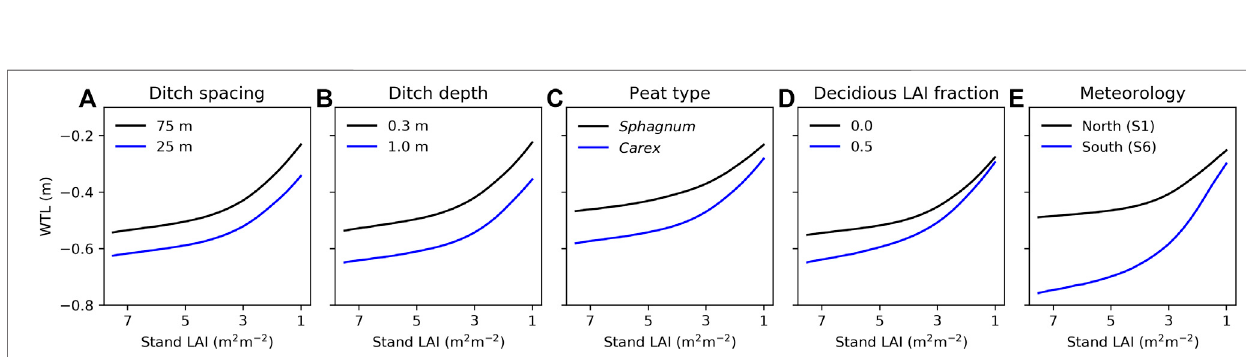
Frontiers in Earth Science |